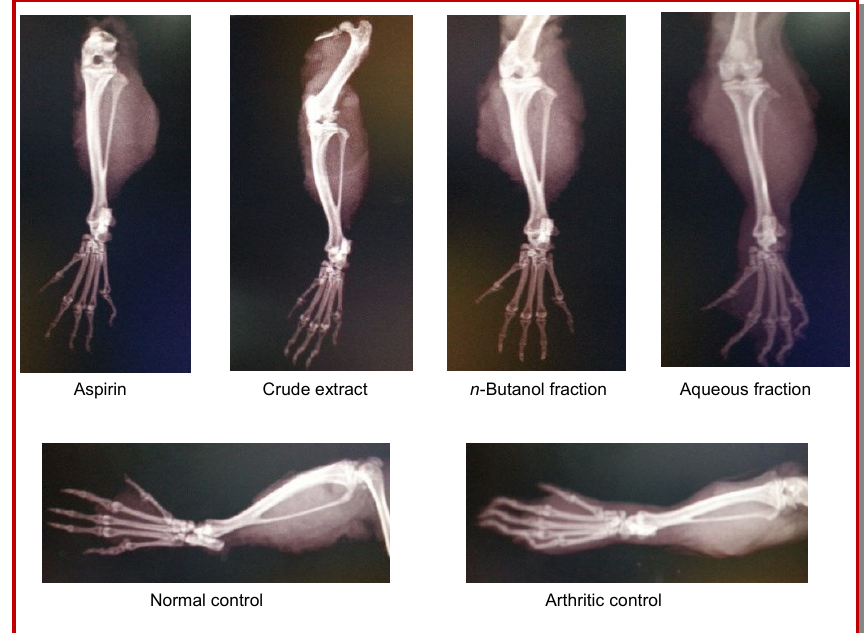
Figure 2: Radiographic analysis of hind limbs of Sprague Dawley rats in CFA-induced arthritis